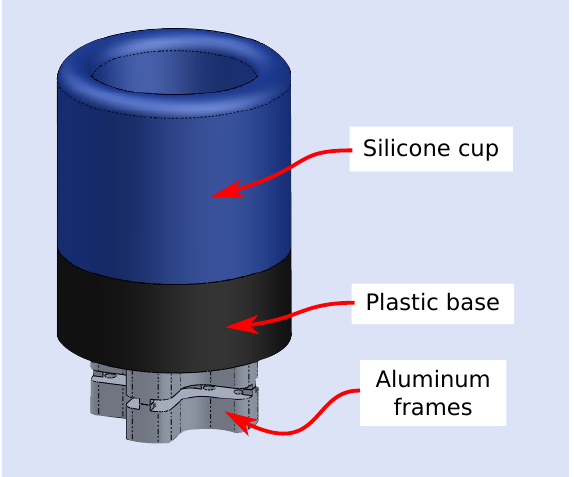
Figure 3. The finger-cup interface attached to a two-part aluminum frame assembly. The 3-DOF sensor fits between the two halves of the frame assembly, which secure together to create a rigid structure on the sensor. A plastic base attaches to the top of this structure to provide a rigid base for a silicone cup. Once secure (using adhesive), the silicone cup provides a comfortable grip onto a user’s finger. The finger forces (and torques) can then be transmitted in total to the body of the